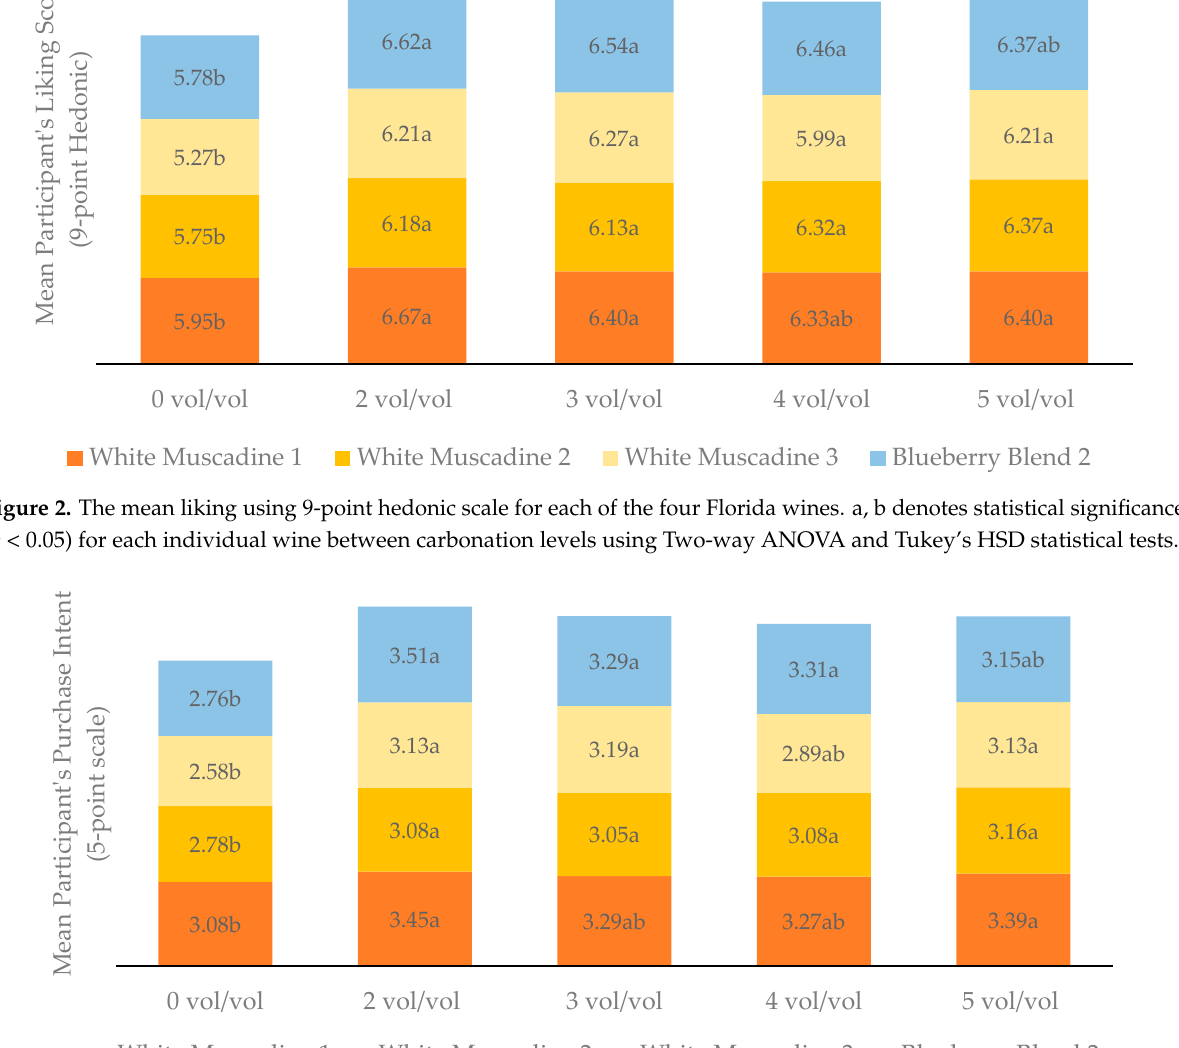
Table 2. Comments indicating attributes for the most preferred and least preferred sample from five Florida fruit and muscadine wines. A green–red heat map is used to indicate the highest number of participants selecting a comment (green) to the lowest (red).